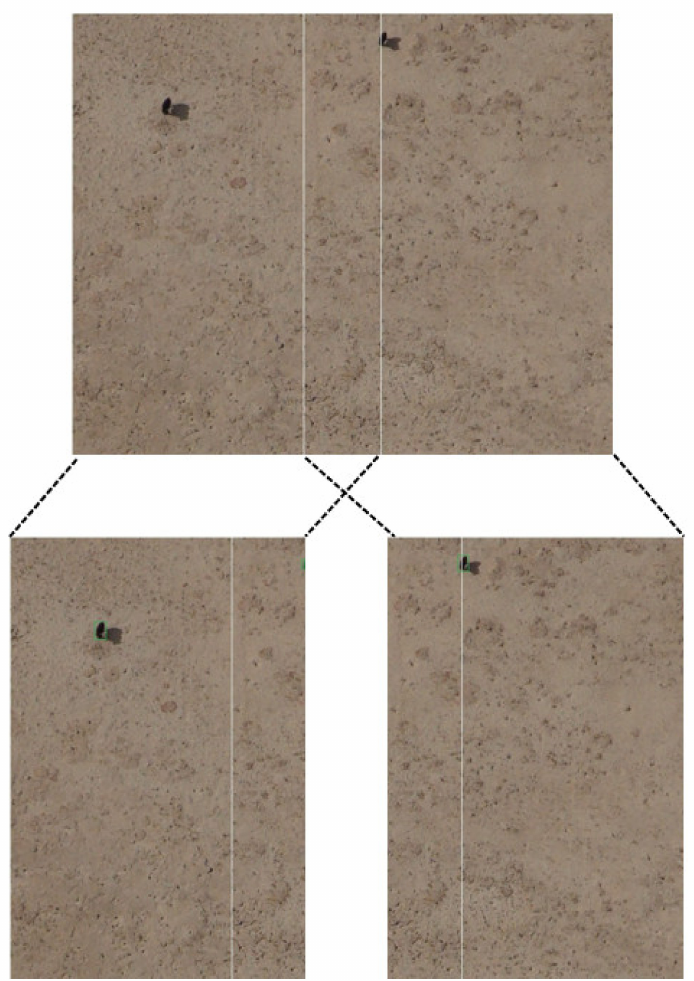
Figure 10. Conventional overlap segmentation method (the green boxes in the figure are the detection result boxes of the original Faster-RCNN model using the original overlapping segmentation